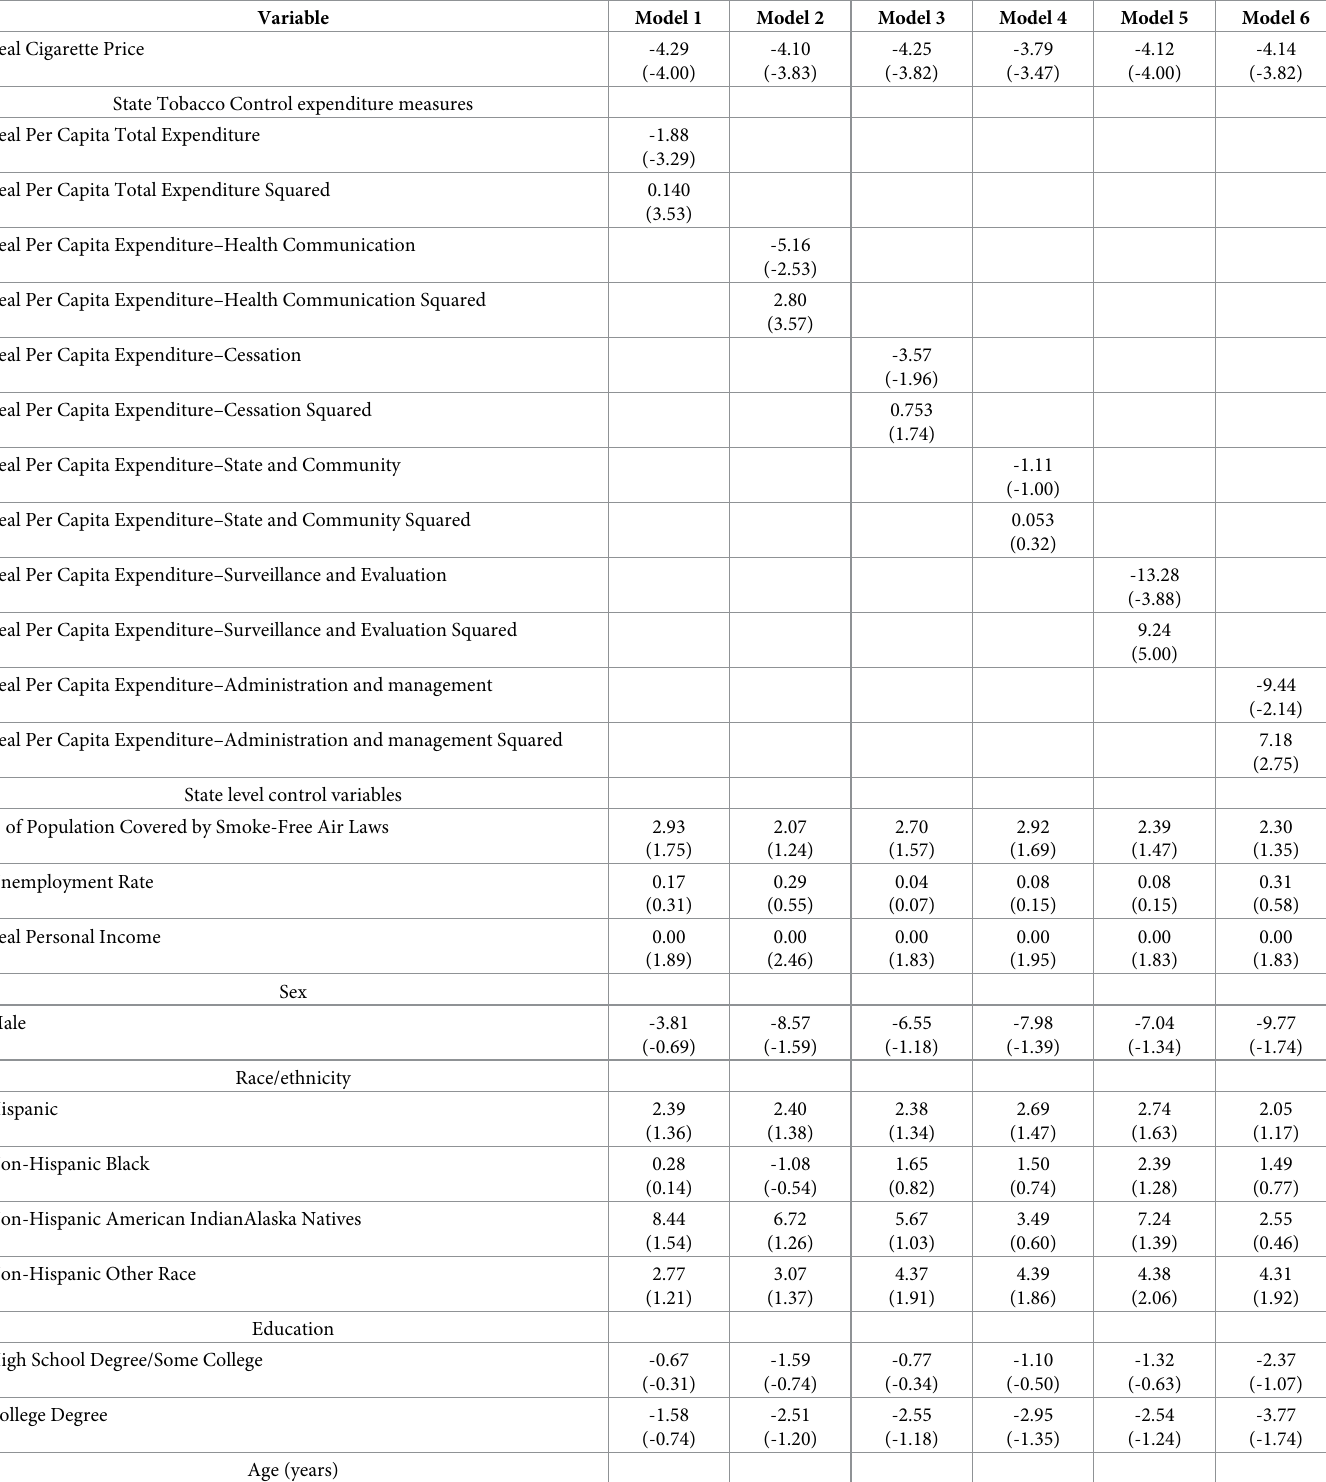
Table 3. Impacts of state tobacco control expenditures by Best Practice category on per capita cigarette sales: United States for years 2008–2012 quadratic